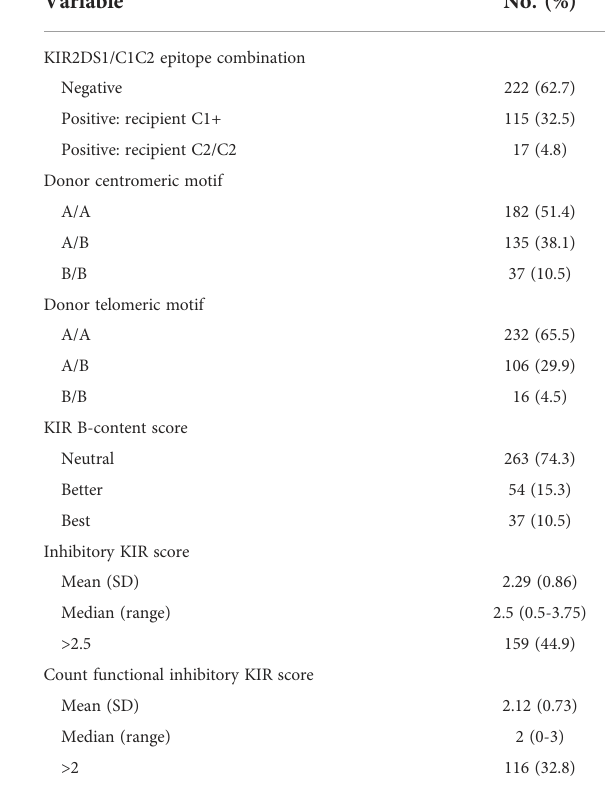
score. The effects of CF-iKIR score on survival persisted after adjustment for other signi fi cant baseline clinical factors, with a hazard ratio (HR) of 0.71 (95% con fi dence interval [CI], 0.52-0.96; P =.029) forPFS(Figure2A) and0.66(95%CI,0.48-0.93; P =.016) for OS (Figure 2B). While the other models failed to predict survival they did show correlations with other transplant outcomes. A high inhibitory KIR score predicted a reduced risk of clinically signi fi cant aGVHD (grade 2-4), with a cumulative incidence at 100 days of 37.4% for low inhibitory KIR score and 28.9% for high inhibitory KIR score (adjusted HR, 0.66; 95% CI, 0.46-0.93; P = .02). The risk of viral reactivation signi fi cantly increased in patients who received a stem cell graft from a donor with NK cell alloreactivity predicted by the NK cell bene fi t model (adjusted HR, 1.30; 95% CI, 1.02-1.66; P = .033). None of the NK cell alloreactivity models predicted relapse, NRM, or cGVHD after HSCT. Results of multivariable analyses of the effect of NK cell alloreactivity according to various models on HSCT outcomes are shown in Table 3.